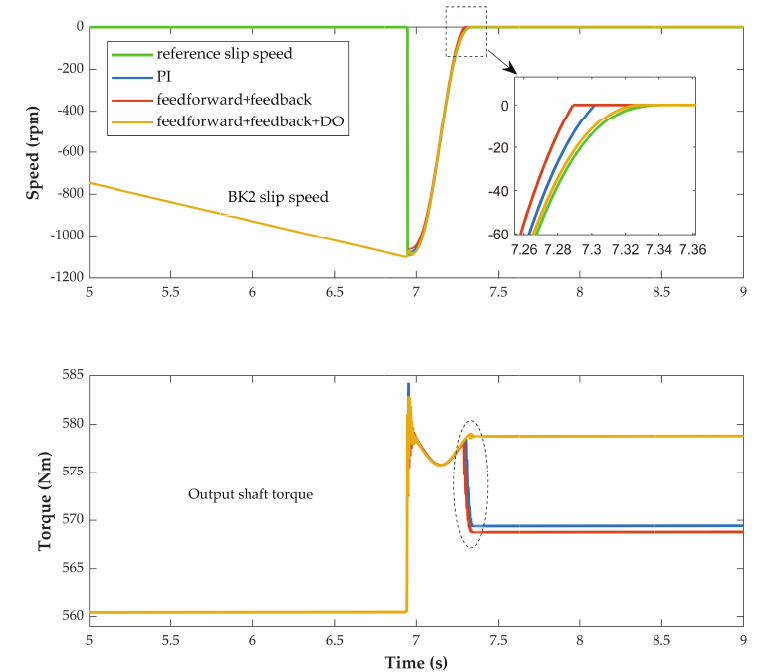
Figure 12. Comparison with non-disturbance-observer (DO)-based